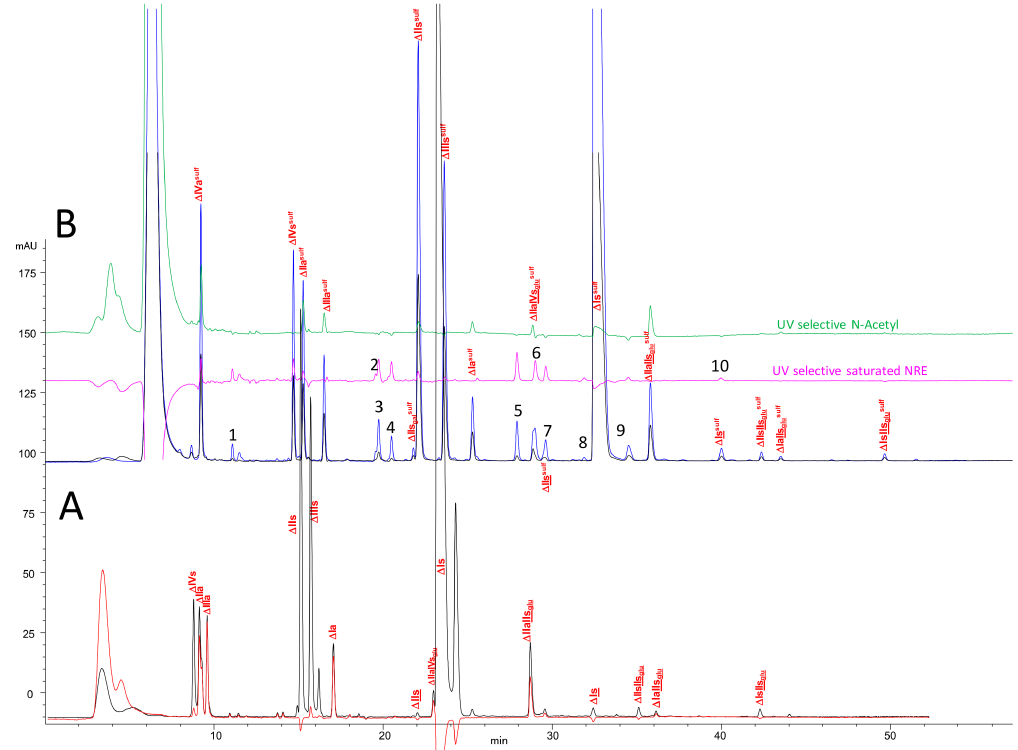
Figure 2. Chromatogram on AS11 of a digest of PMH. ( a ) without reductive amination ( b ) with sulfanilic tagging. Detection: — 265 nm; — 232 nm; — 202–242 nm; — 265 nm − 2.21 × 232 nm; — 200 nm − 1.28 × 265 nm. Peak assignment: 1: GlcNS sulf , 2: GlcN(NS,3S) sulf , 3: GlcN(NS,6S) sulf , 4: Mw 515 sulf U(2,1,0) sulf , 5: IIs glusulf : (GlcA-GlcN(NS,3S,6S)-SA), 6: Is idsulf : IdoA(2S)-GlcN(NS,6S)-SA, 7: GlcN(NS,3S,6S) sulf